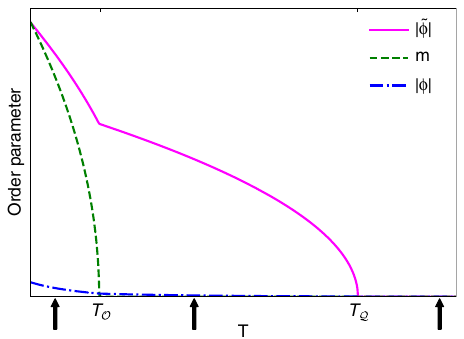
Fig. 1 Phase diagram at zero magnetic fi eld [ h = 0]. The temperature regimes studied in Table 1 and in Supplementary Note 4 are denoted by vertical arrows at: T < T parameters for AF Q , F O , and F Q are denoted by j ~ ϕ j , m , and | ϕ |, respectively. AF Q and F O spontaeously order at T